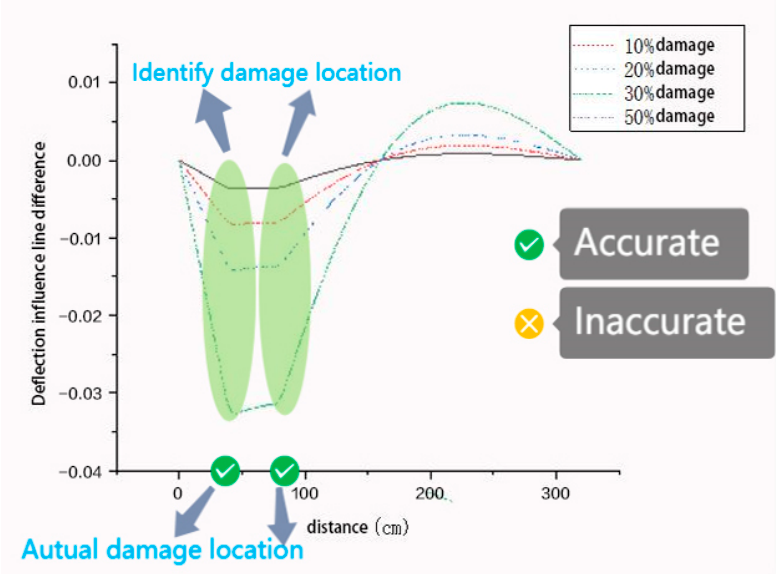
Figure 17. Deflection influence line difference of 1/4 determining point of the 1st span following work condition 2 (2-5).